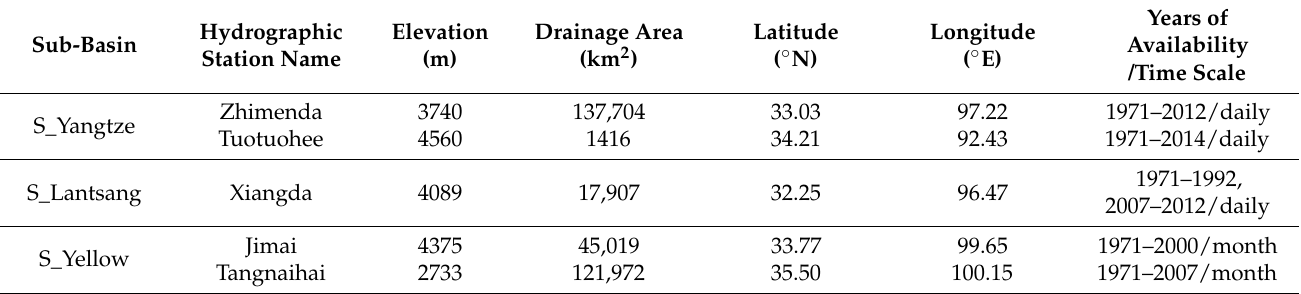
Table 2. Hydrological stations across